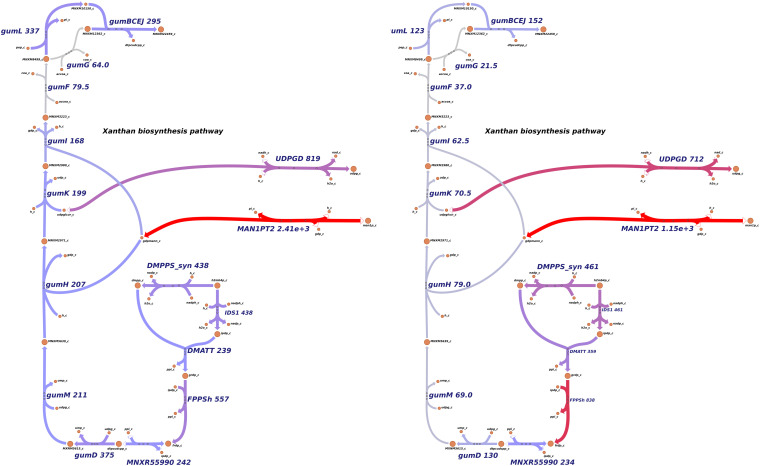
Differential expression of genes involved in xanthan production. Levels of transcript abundance were mapped to the metabolic pathway of xanthan. (A) Xpm CIO151 EV. (B) Xpm CIO151 ΔrpfCGH-EV. Xanthan production genes were downregulated in Xpm CIO151 ΔrpfCGH-EV when compared with Xpm CIO151 EV and analyzed in NOISeqBIO (King et al., 2015). The transcript abundance of Xpm CIO151 ΔrpfCGH-EV is half of that of the Xpm CIO151 EV. Seven gum genes (gumM, gumK, gumI, gumH, gumG, gumF, and gumD) were upregulated by the quorum sensing pathway. Transcriptomic abundances were mapped into Escher maps. The purple color in the maps corresponds to low abundance and the red color to high abundance. The median of the transcript abundances (FPKM) defined the middle point of coloring (gray). Therefore, values below the median are colored purple and above the median red. When in the reaction rule two or more genes are strictly necessary (AND Boolean rule), the mean of the abundance was calculated. The thickness of the lines is proportional to the abundance of the transcripts involved in the given reaction. Constructed in Escher (King et al., 2015).